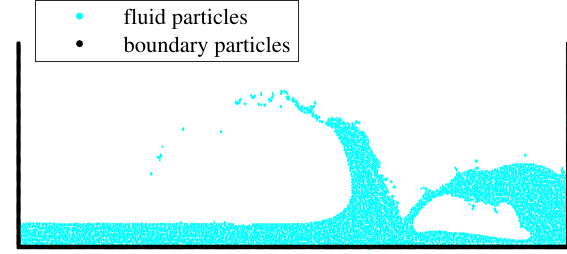
Fig. 4. The jet after the rolling wave impact. T = 7 .